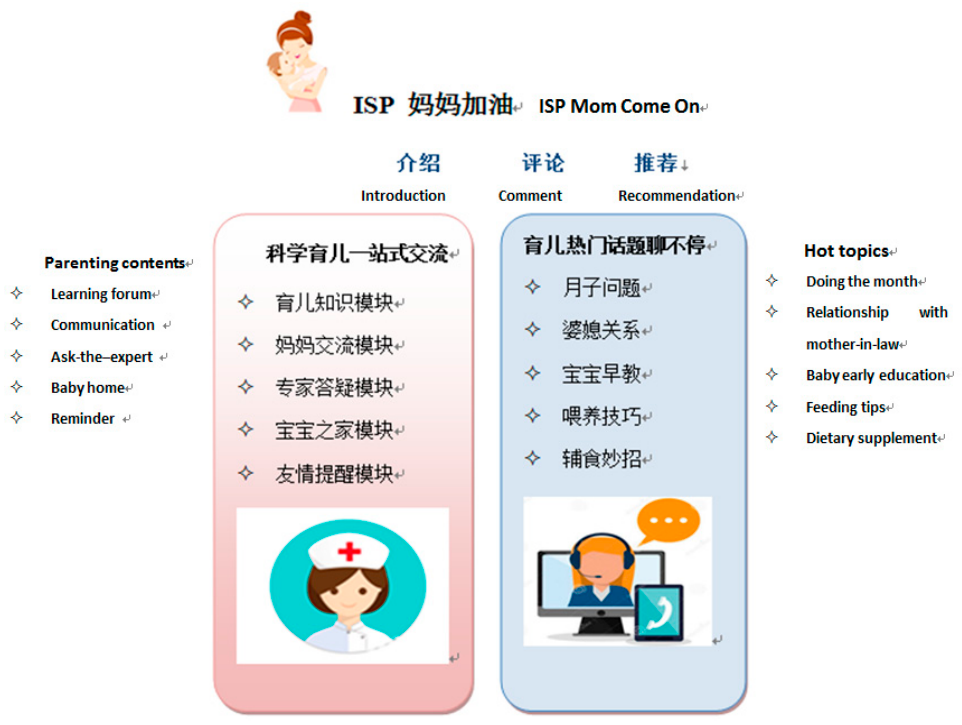
Figure 2. The interface design of “ISP” APP.